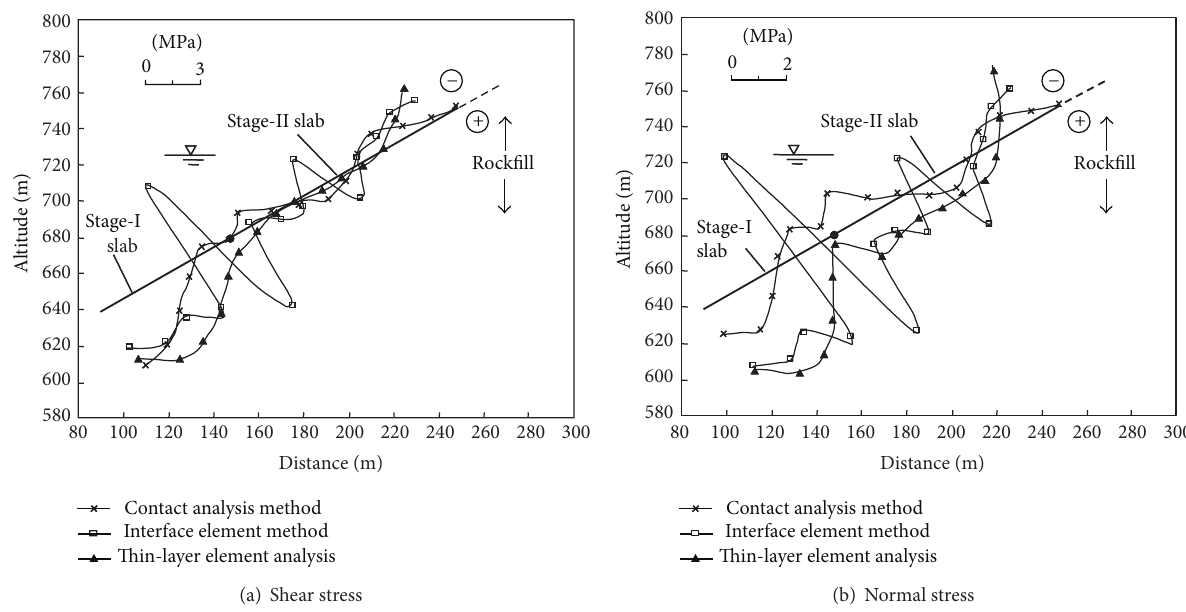
Figure 14: Comparison of stresses in the concrete face slab at completion of the dam body